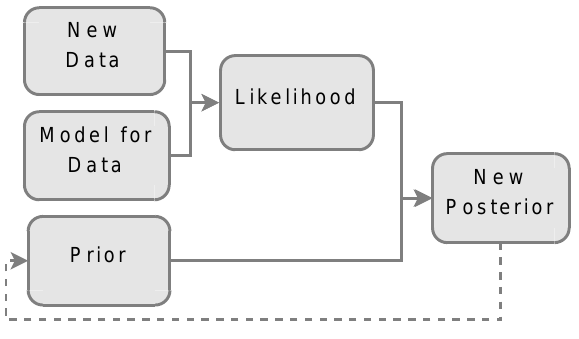
Fig. 8. Bayesian Updating